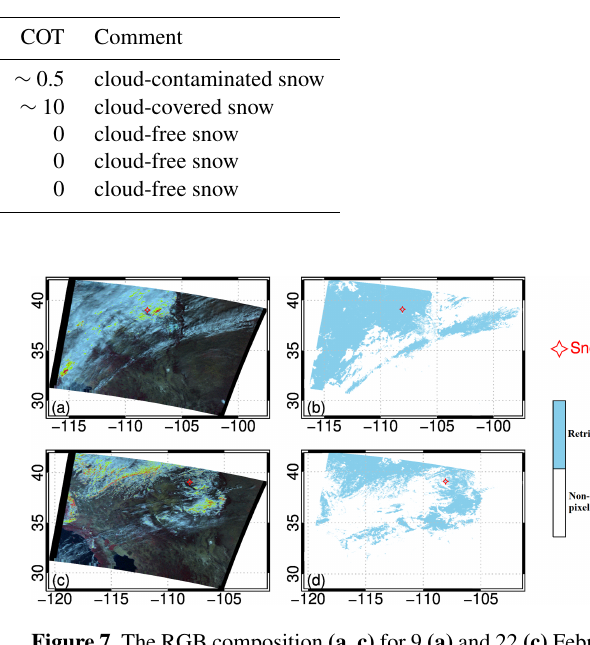
Figure 7. The RGB composition (a, c) for 9 (a) and 22 (c) February when XBAER detected cloud-free snow and provided the retrieval. The XBAER cloud screening results (b, d) for the corresponding days are given in (b) and (d) . “Retrieved pixel” refers to cloud- free snow. “Non-retrieved pixel” refers to the area where XBAER retrieval is not performed; this includes (1) snow-free and cloud- free, (2) cloud above snow, and (3) cloud above